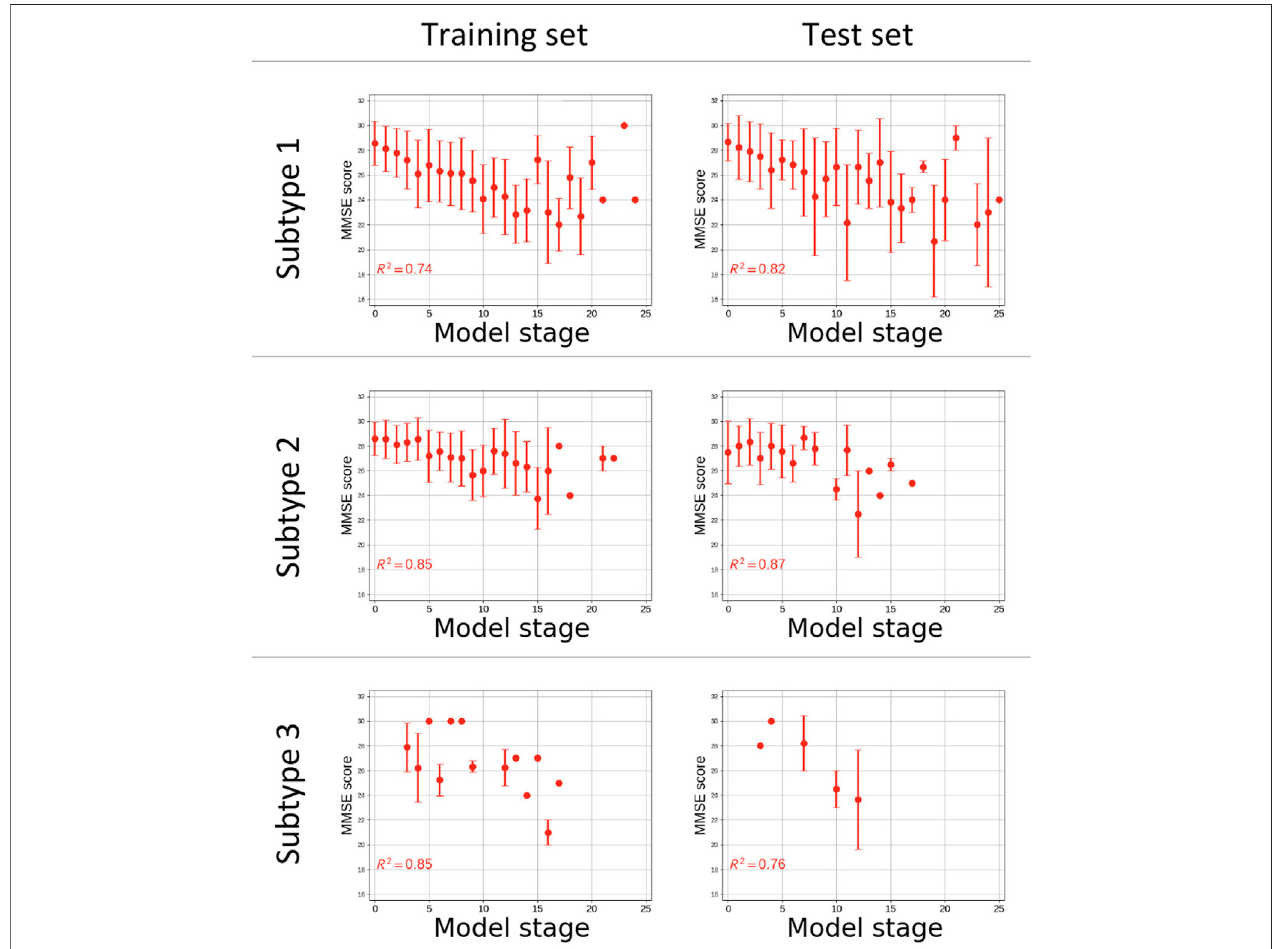
FIGURE5| PlotofCognitiveperformancemeasuredbyMiniMentalStateExamination(MMSE)vs.theestimateddiseasestagesubjectsfromthetraining (left) and test (right) setsforeachsubgroup.Coef fi cientsofdetermination(R 2 )ofthelinearregressionofMMSEscorevs.diseasestagearereported.The x -axesareonlyreported up to stage 25 of 39 as no subjects were staged